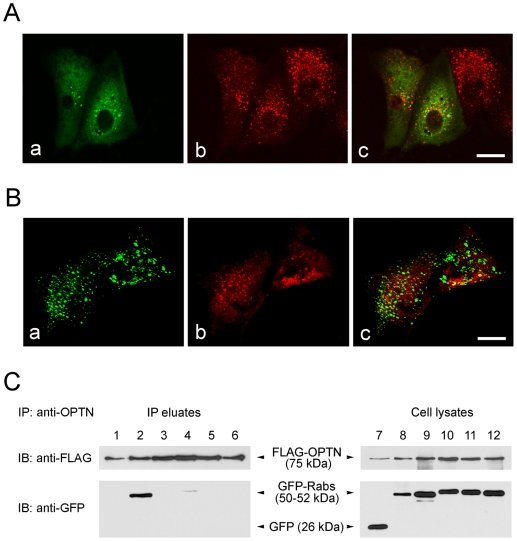
Lack of interactions between wild type optineurin (OPTNWT) and endocytic markers on the Tf uptake route.(A) RPE cells transfected to express OPTNWT-GFP (Aa, green) were immunostained with anti-EEA1 (Ab, red). (B) RPE cells co-transfected with pTarget-FLAG-OPTNWT and pGFP-Rab5WT (Ba, green) for 16 h were immunostained with anti-FLAG antibody (Bb, red). Merged images are presented in Ac and Bc. Optineurin foci largely did not colocalize with EEA1 (A) or Rab5 (B). Scale bar, 20 µm. (C) Co-immunoprecipitation (IP) of optineurin with Rab proteins. RPE cells expressing FLAG-OPTNWT along with GFP (lanes 1 and 7), GFP-Rab8 (lanes 2 and 8), GFP-Rab4 (lanes 3 and 9), GFP-Rab5 (lanes 4 and 10), GFP-Rab11 (lanes 5 and 11), or GFP-Rab7 (lanes 6 and 12) were immunoprecipitated with anti-optineurin. The resulting IP eluates (lanes 1–6) were immunoblotted (IB). The 75-kDa FLAG-OPTN and 50–52-kDa GFP-Rabs were detected by anti-FLAG and anti-GFP antibodies, respectively. Thirty micrograms of cell lysates (lanes 7–12) were analyzed with the same antibodies to evaluate the expression level of fusion proteins.